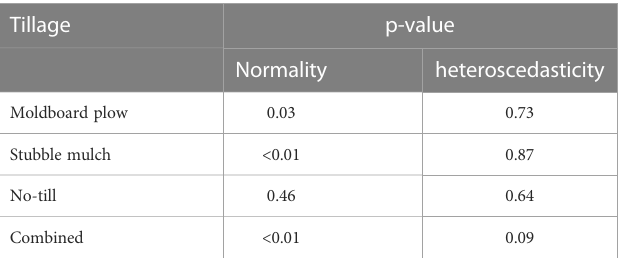
TABLE 1 Test for normality and heteroscedasticity (non-constant variances of the error term) in the data for the different tillage practices.